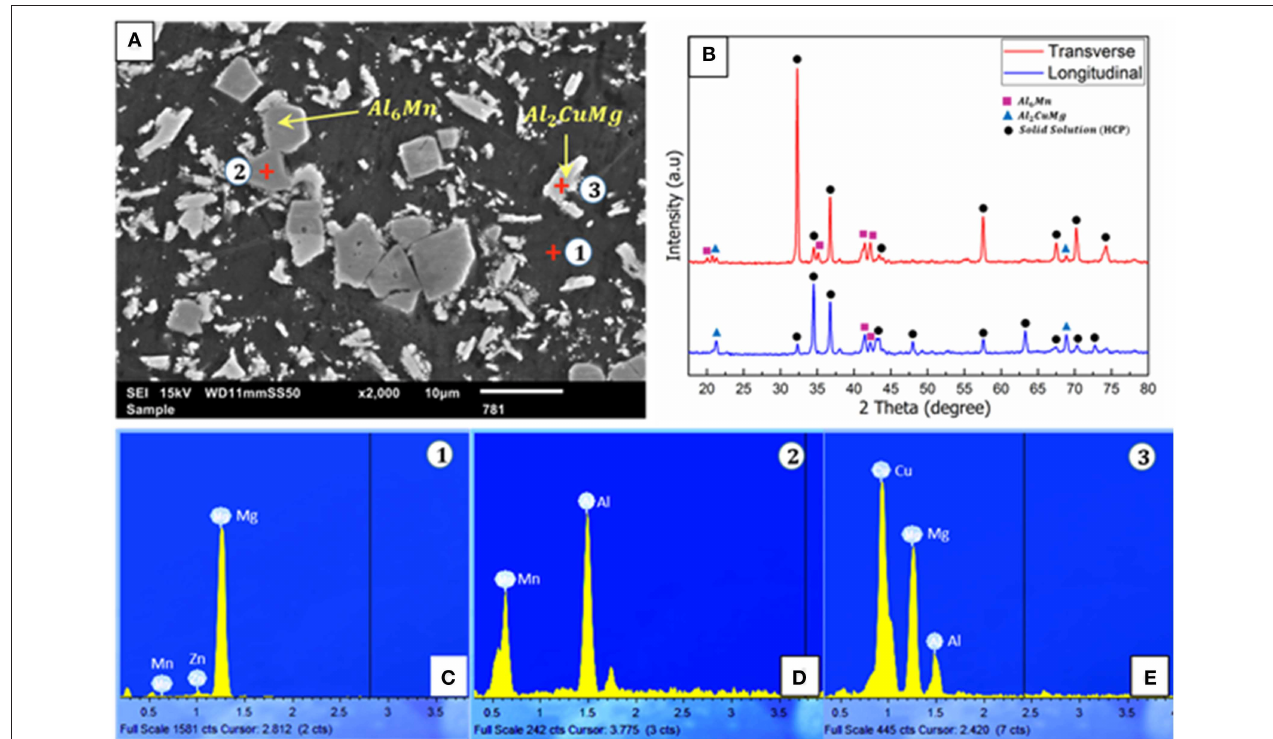
FIGURE 1 | SEM, XRD, and EDS results of Mg 80 Al 5 Cu 5 Mn 5 Zn 5 MCA. (A) SEM micrograph reveals the presence of three phases, base matrix, polyhedron phase, and smaller scattered precipitates. (B) XRD results revealing the presence of Mg hcp structure as a dominating phase together with the presence of Al 6 Mn and Al 2 CuMg phase. (C–E) EDS spectrums taken on three different phase location (1, 2, and 3) in SEM micrograph (A) , further verified the presence of Mg-base solid solution matrix with Al 6 Mn and Al 2 CuMg as embedded